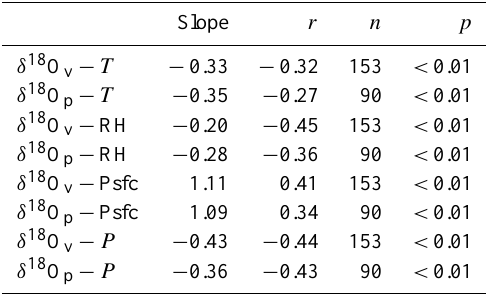
Table 2. Correlations between stable oxygen isotope ( δ 18 O v and δ 18 O p ) and meteorological factors (temperature, relative humidity, surface pressure, and precipitation amount) at